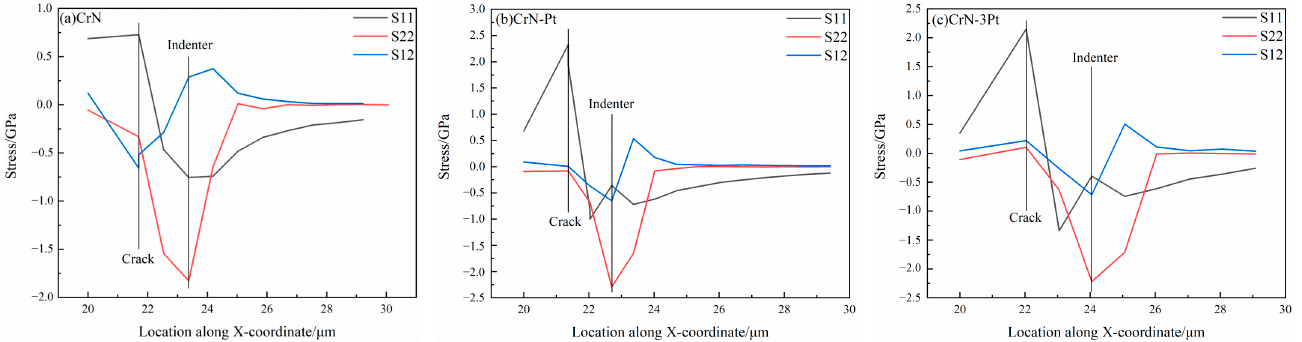
Figure 4. Isotropic stress distribution along the X-direction on the surface of three coatings. ( a ) CrN; ( b ) CrN-Pt; ( c ) CrN-3Pt.